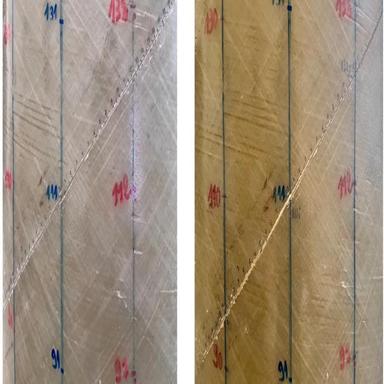
(a) Intact pipe, (b) Cracked pipe = 12 cm, (c) 40 cm, and (d) 60 cm.